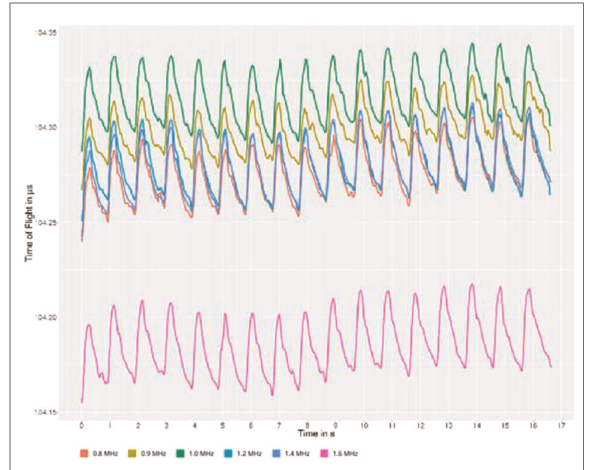
FIGURE 3 Typical multispectral ultrasonic curves can be observed on the monitor of the device during the examination. The x -axis represents the timescale, and the y -axis represents the time difference between sending and receiving the ultrasound signal of a speci fi c frequency, called time of fl ight. The color codes represent different frequencies of ultrasound.